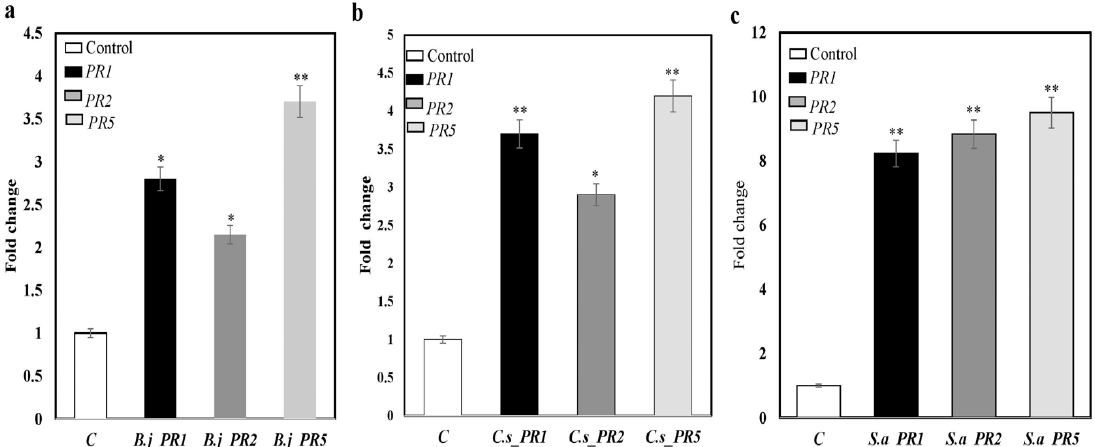
Figure 4. Expression analysis of SA marker genes ( PR1 , PR2 , and PR5 ) in ( a ) B. juncea , ( b ) C. sativa , and ( c ) S. alba after powdery mildew infection. Error bars based on standard error were calculated from three biological replicates (* p < 0.05; ** p < 0.01). Asterisks shows statistically significant (* p < 0.05) or extremely significant (** p < 0.01) between control and infected plants.